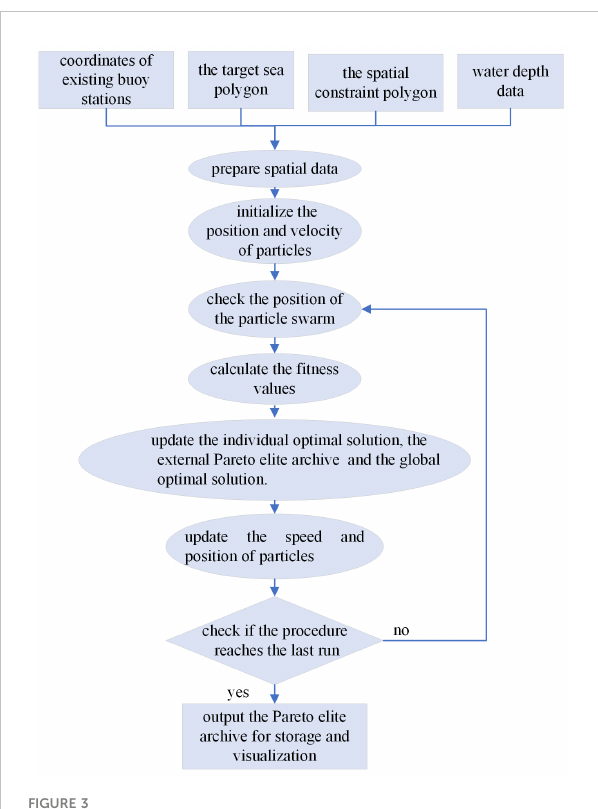
FIGURE 3 The work fl ow of the customized heuristic approach based on the MOPSO algorithm to solve